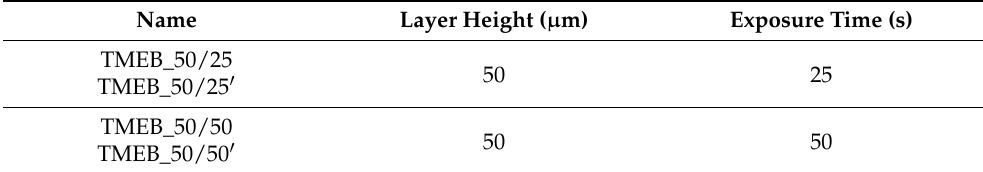
Table 3. Printer parameters for drug-loaded